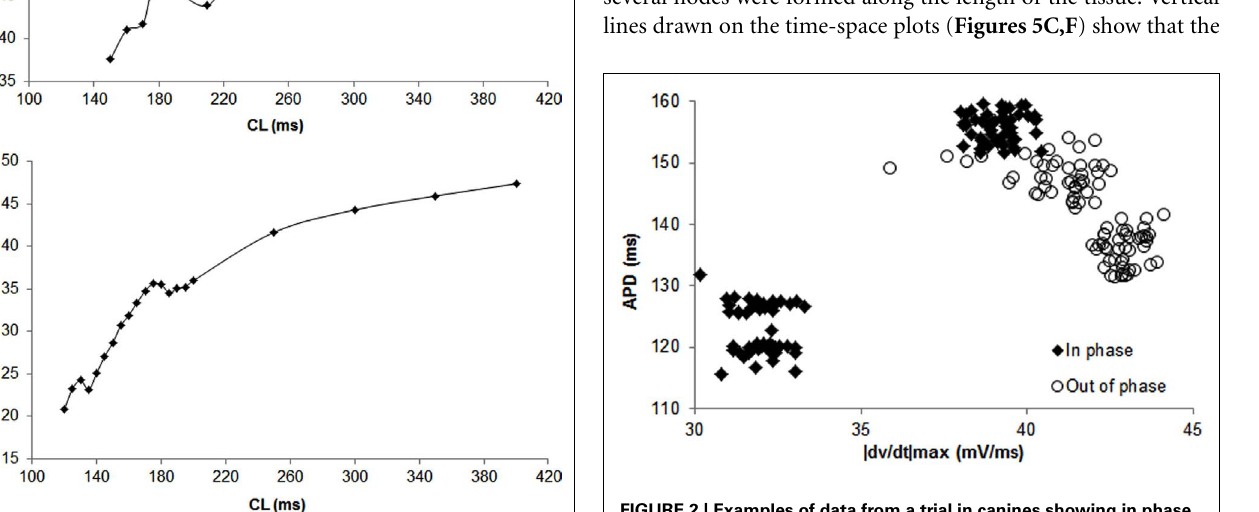
FIGURE 2 | Examples of data from a trial in canines showing in phase (closed diamonds) and out of phase (open circles) relationship betweenAPD and its preceding |d v /d t | max , i.e.,APD and |d v /d t | max for the same beat. These data were obtained using constant CL